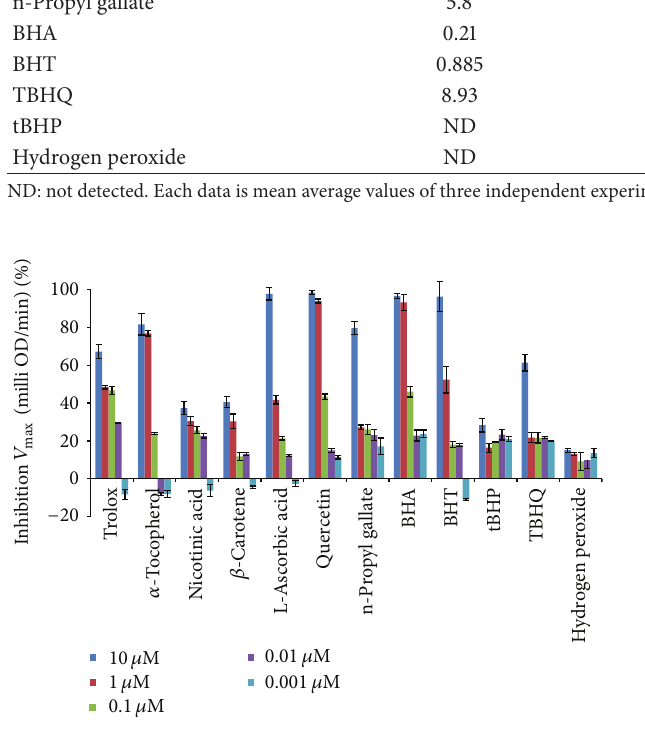
Figure 3: Percent inhibition calculated on the basis of 𝑉 max (mil- liOD/min) of the kinetic curve.